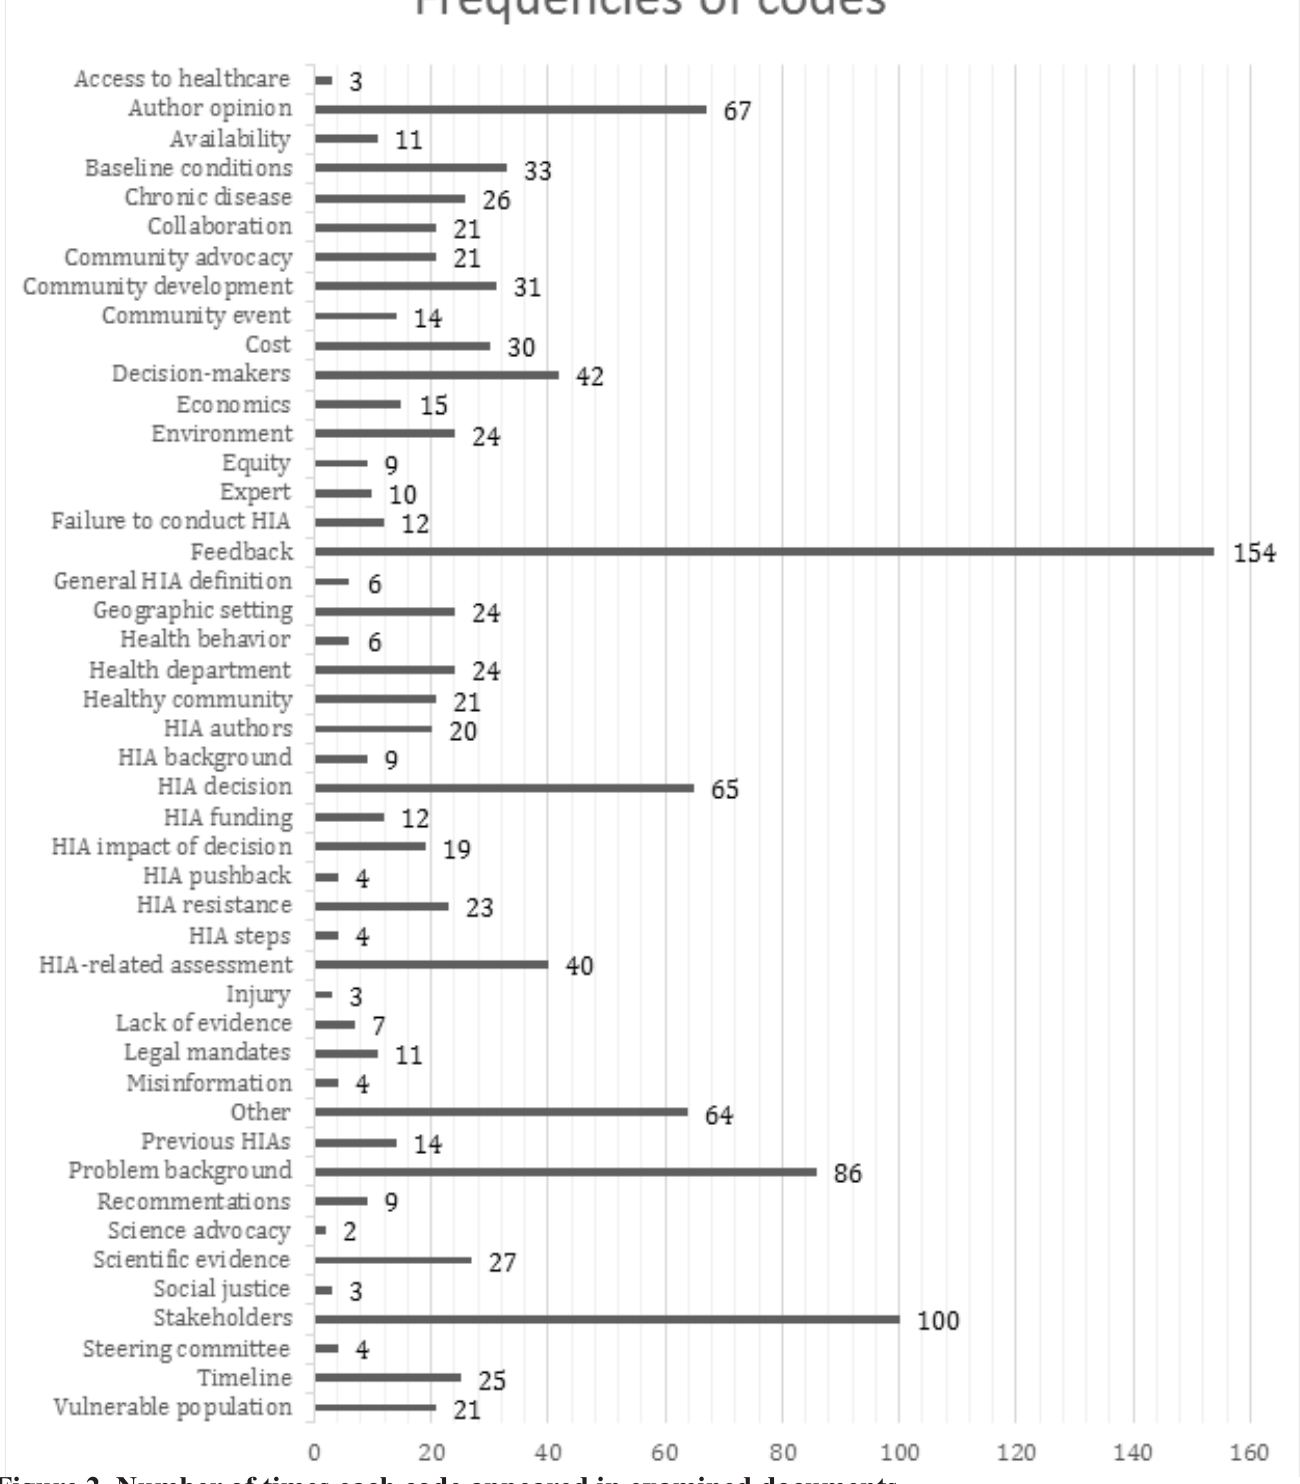
Figure 2. Number of times each code appeared in examined